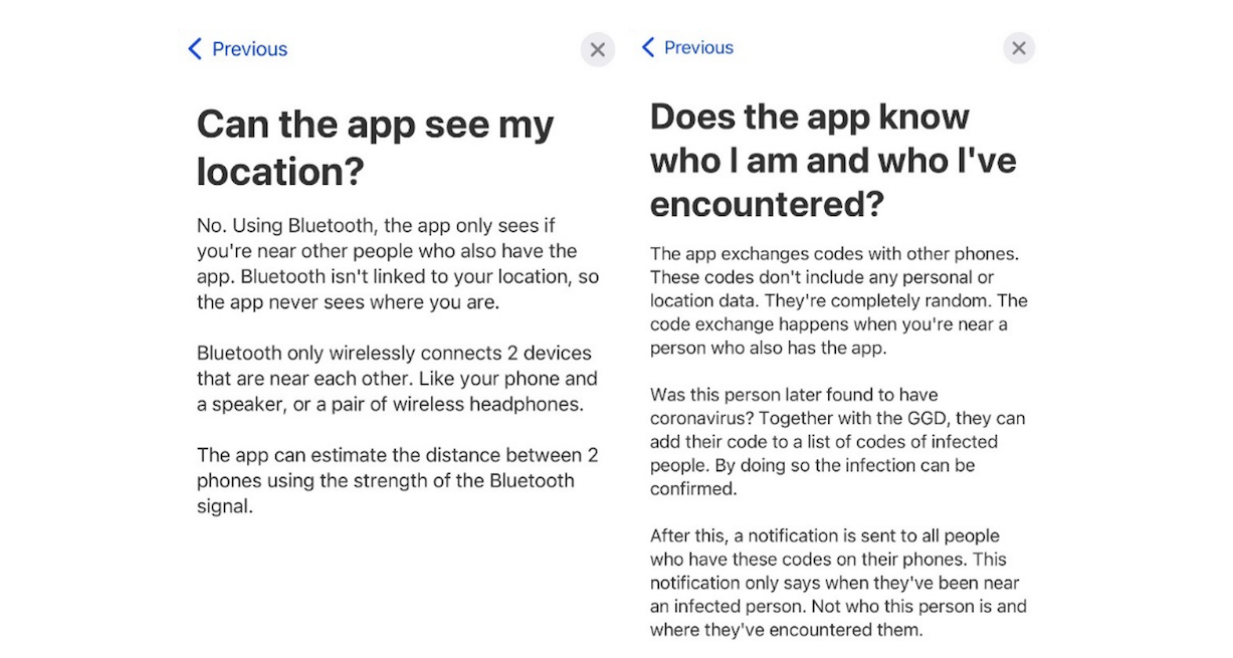
Figure 7. Screenshot of frequently asked questions, with responses (left) indicating that the app does not track users’ GPS and (right) how the app is